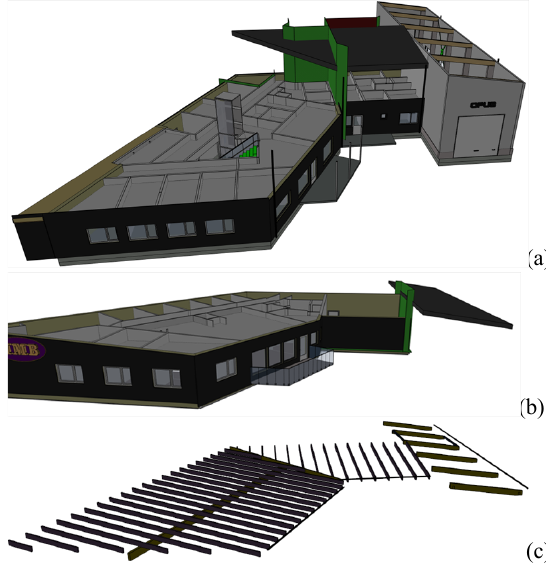
Figure 3. Grouping of entities in storey 1 (a), storey 2 (b) and